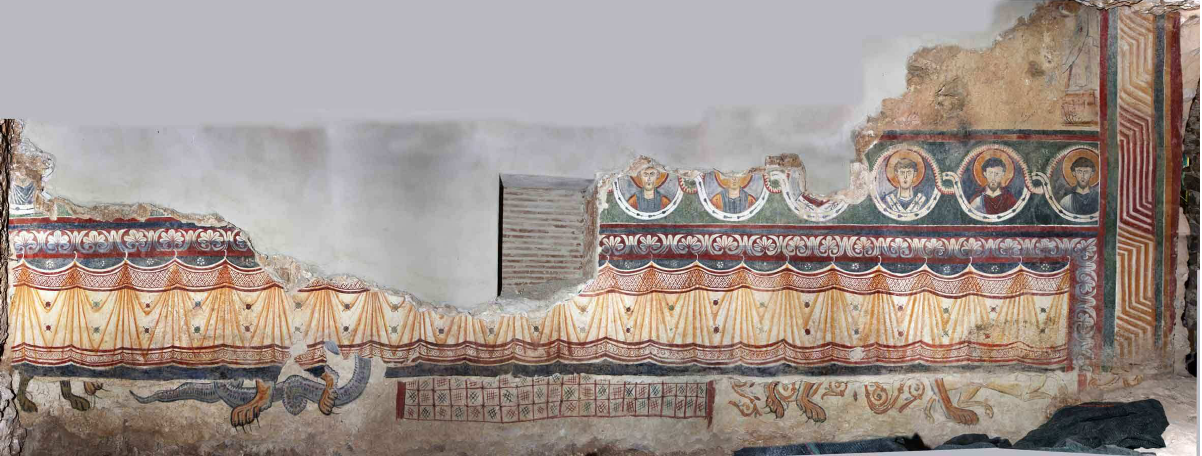
Figure 5. Italy, Fondi, San Magno church, apse, development of the cylindrical surface, M. Carpiceci